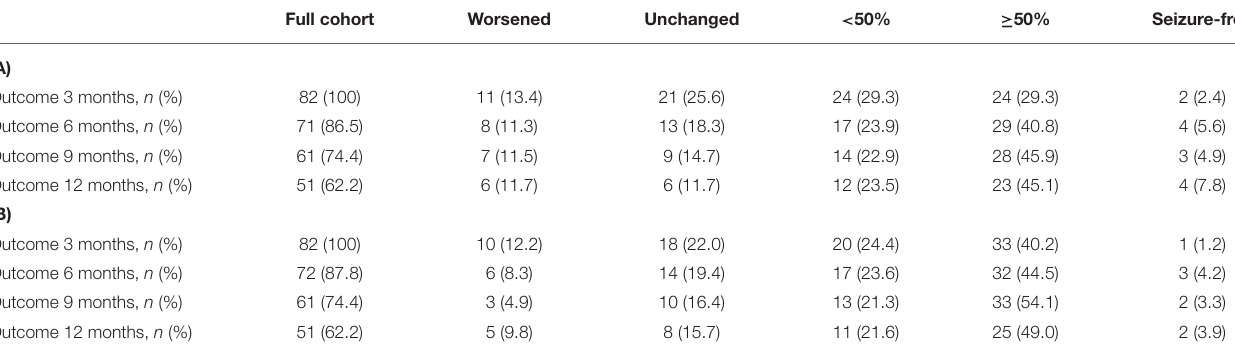
TABLE 2 | Treatment response rate for convulsive seizures (A) and total seizures (B). Full cohort Worsened Unchanged < 50% ≥ 50% Seizure-free